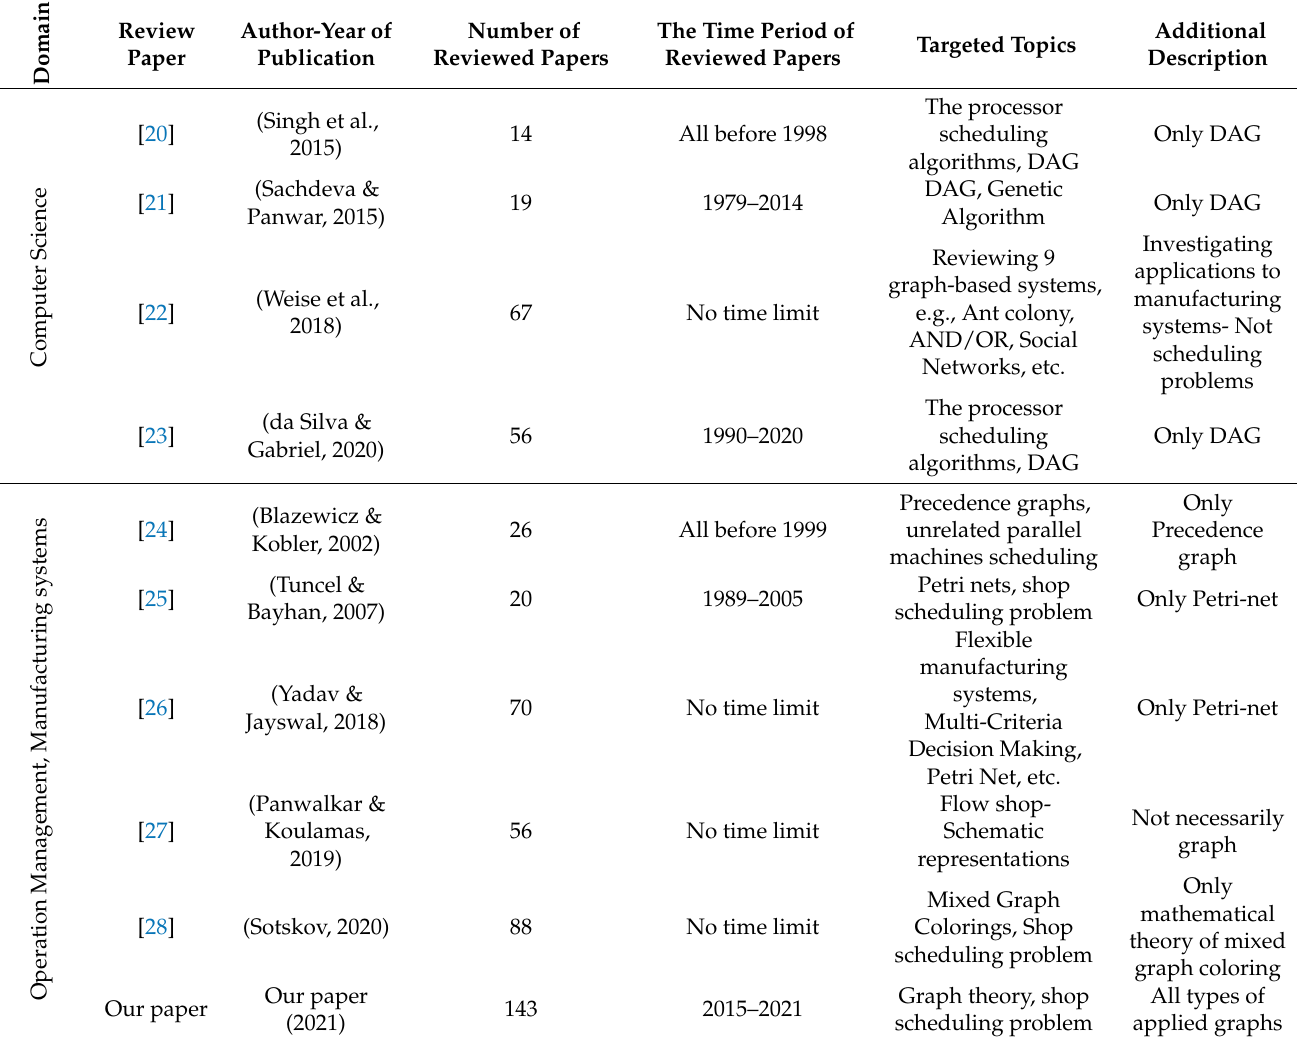
Table 1. Comparing the existing review papers in the literature with this